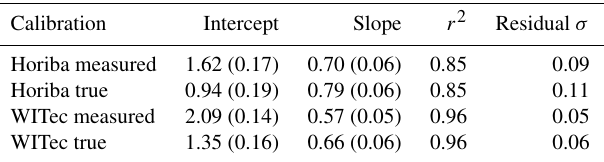
Table 2. Regression equations between mean ν 1 FWHM and (cid:127) Ar . Calibration Intercept Slope r 2